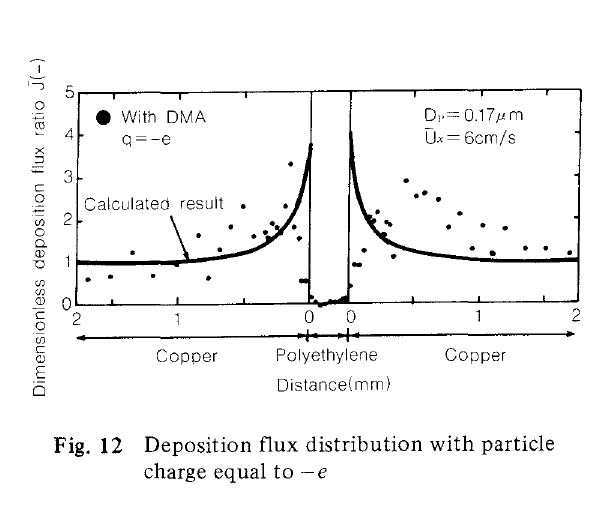
Fig. 12 Deposition flux distribution with particle charge equal to-e